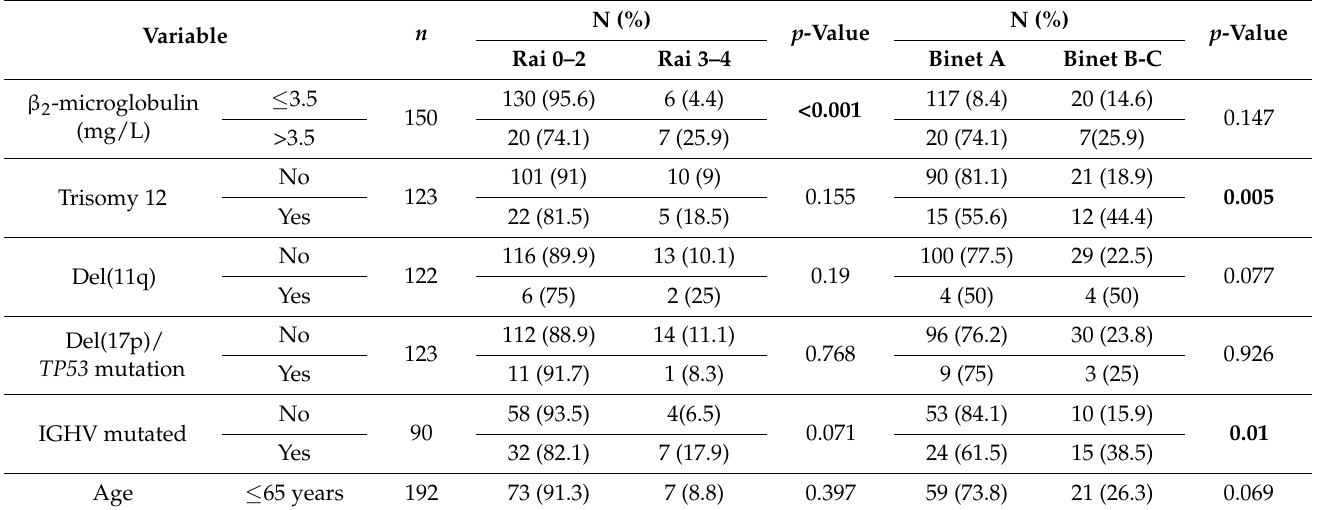
Table 2. Association of the five CLL-IPI prognostic variables [18] and del(11q) with Rai/Binet staging. n : number of data considered. Significant values (according to the Cox regression) are shown in bold.